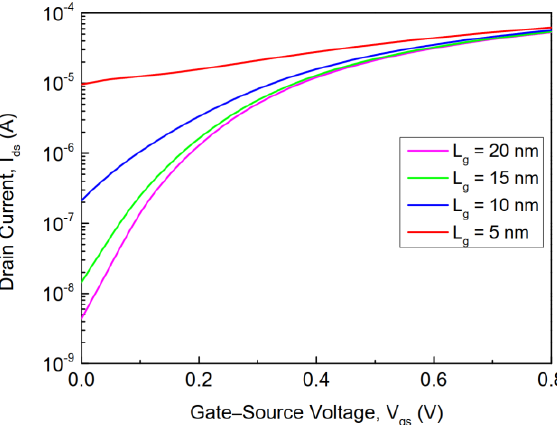
Figure 18. Cut-off frequency as a function of gate – source voltage with different gate lengths at V ds = 0.05 V.